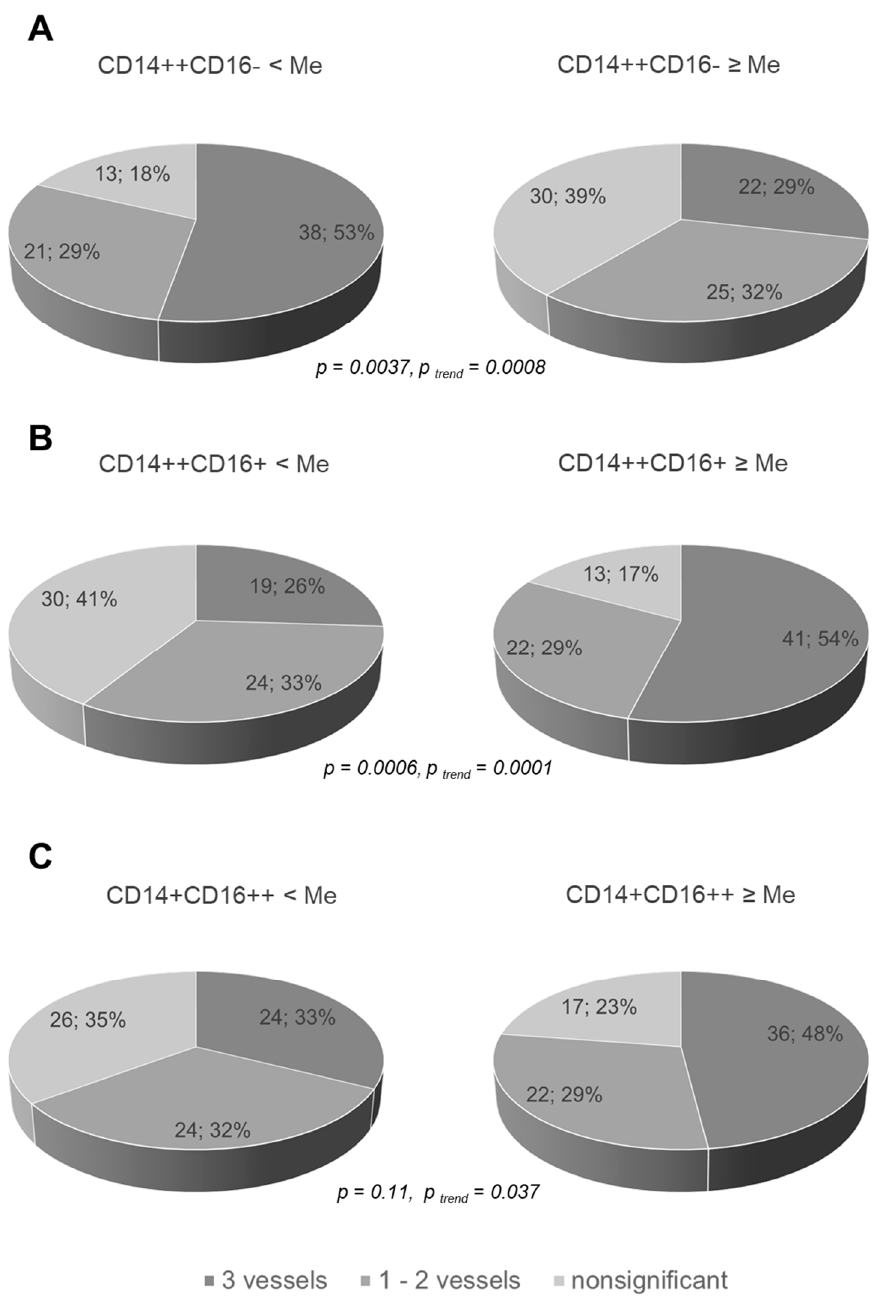
Figure 3. Coronary atherosclerosis and the percentage of the monocyte subsets. Data are presented as absolute numbers and the percentage of patients with a varying severity of coronary artery disease depending on the relative of the monocyte subset below and above the median. The median value for classic CD14 ++ CD16 − monocytes was 73.6%, intermediate CD14++ CD16+ was 7.3% and non ‐ classical CD14 + CD16++ was 16.4%. ( A )— classical CD14++CD16 − , ( B )—intermediate CD14++CD16+ and ( C )—non ‐ classical CD14+CD16++ monocytes. Me =